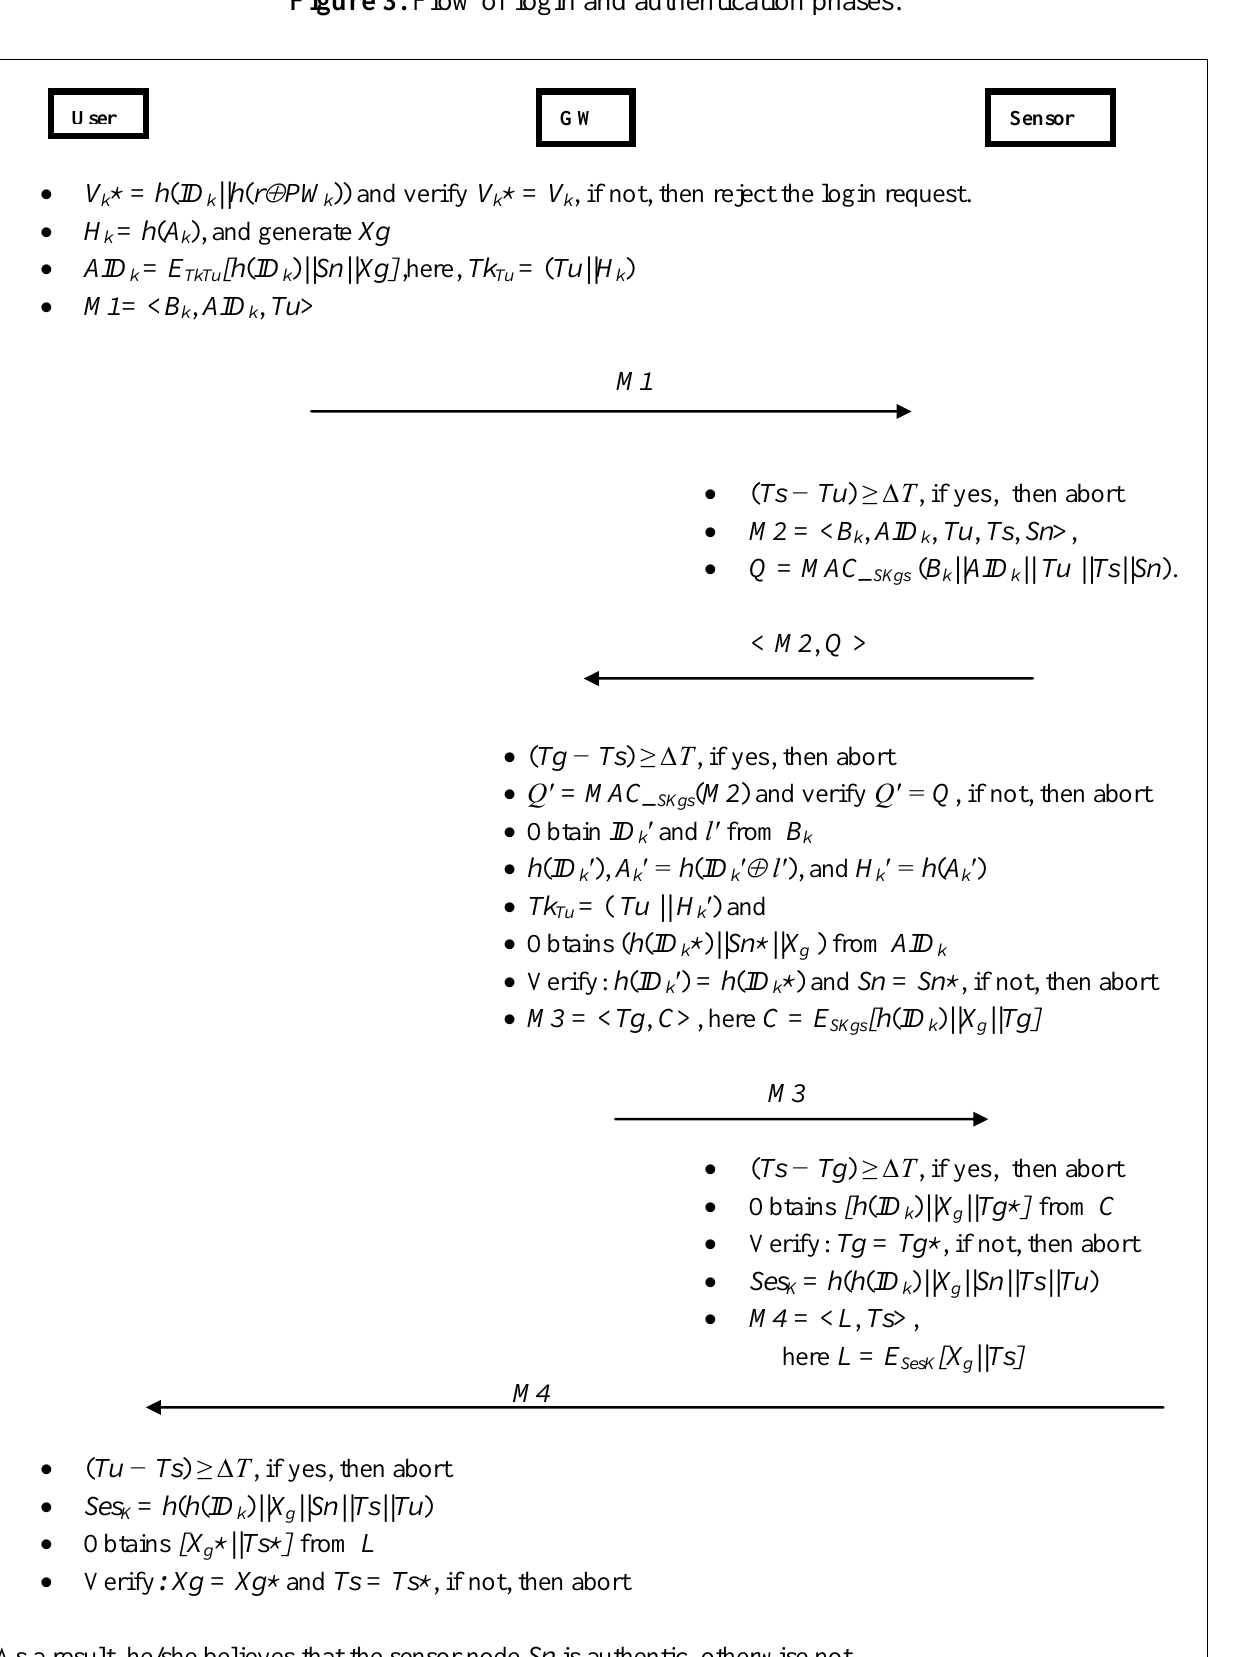
Figure 3. Flow of login and authentication